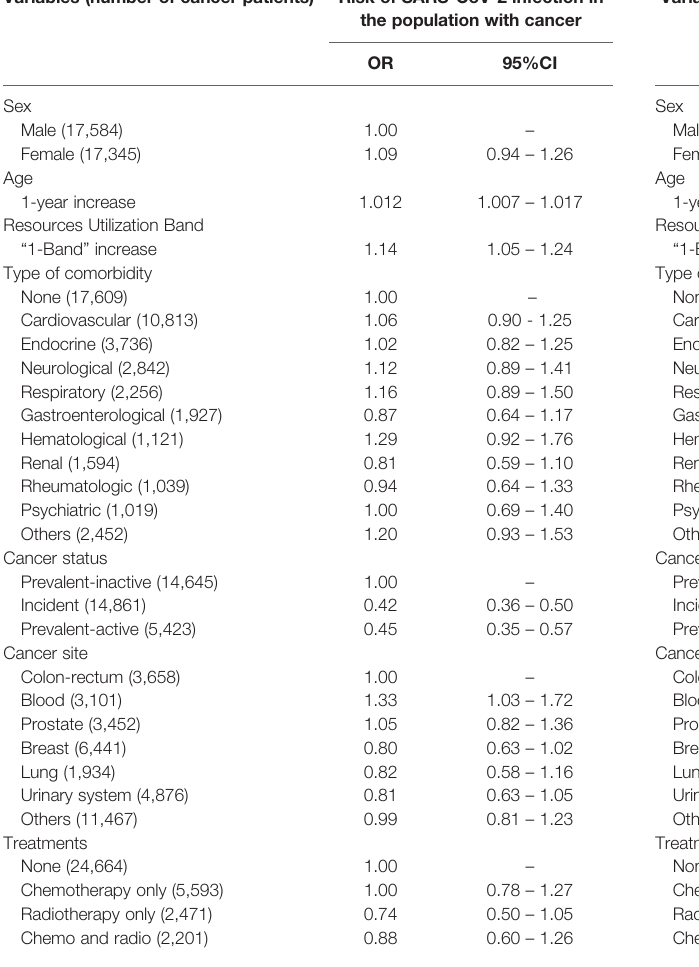
TABLE 3 | Risk of death among CoV2+ ve cancer patients: multivariable logistic regression model. Variables (number of cancer the population with cancer OR